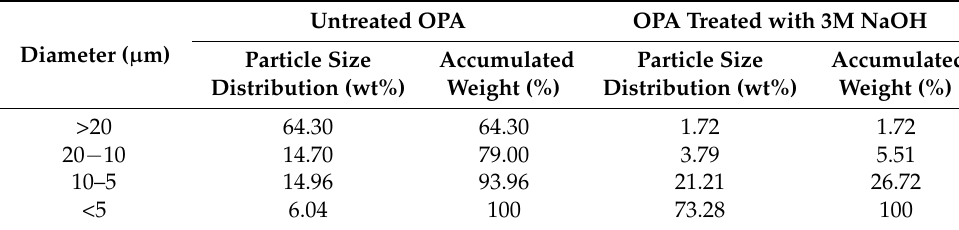
Table 3. Particle size distribution of untreated OPA and OPA treated with 3M NaOH.